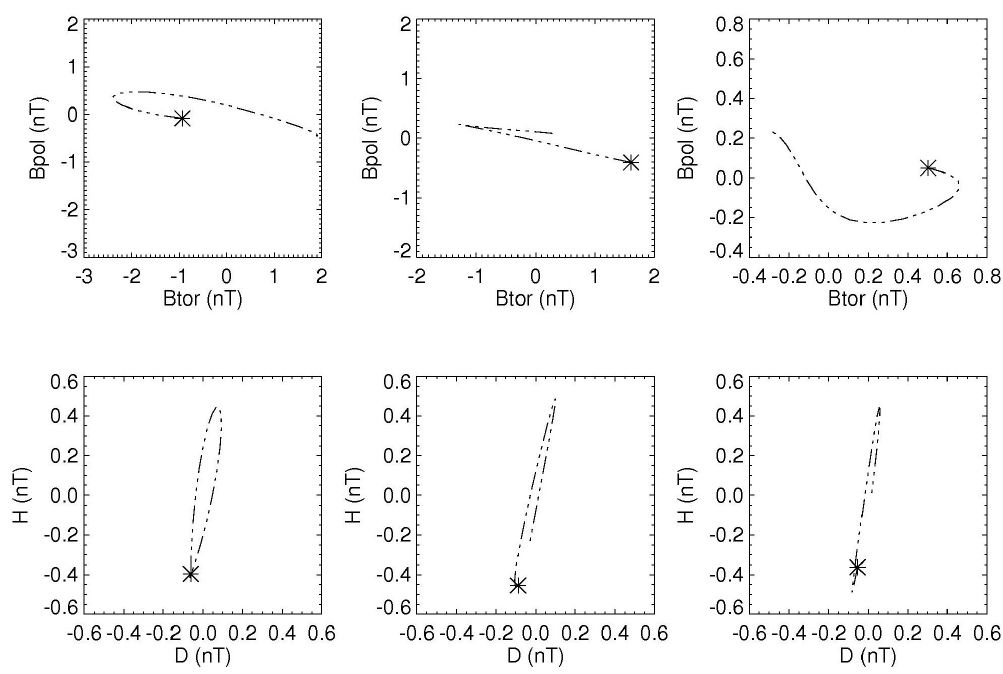
Fig. 6. CHAMP (top panel) and ground (bottom panel) wave hodograms for three consecutive 20s intervals at the time when the satellite was over the Hermanus ground